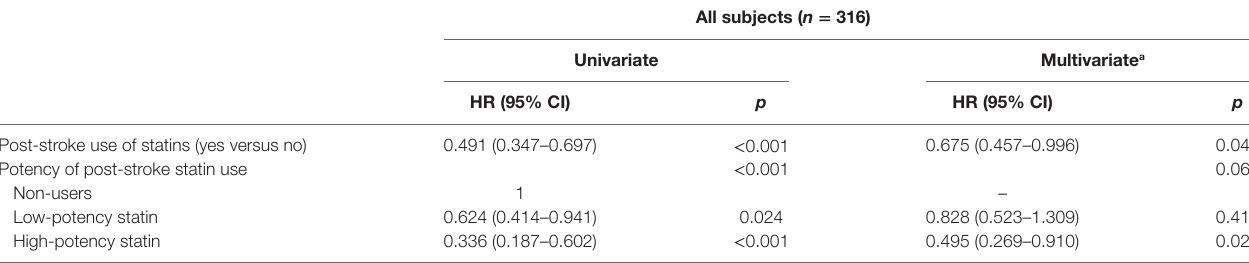
TaBle 2 | Analyses of univariate and multivariate Cox’s proportional hazard model for predicting mortality.